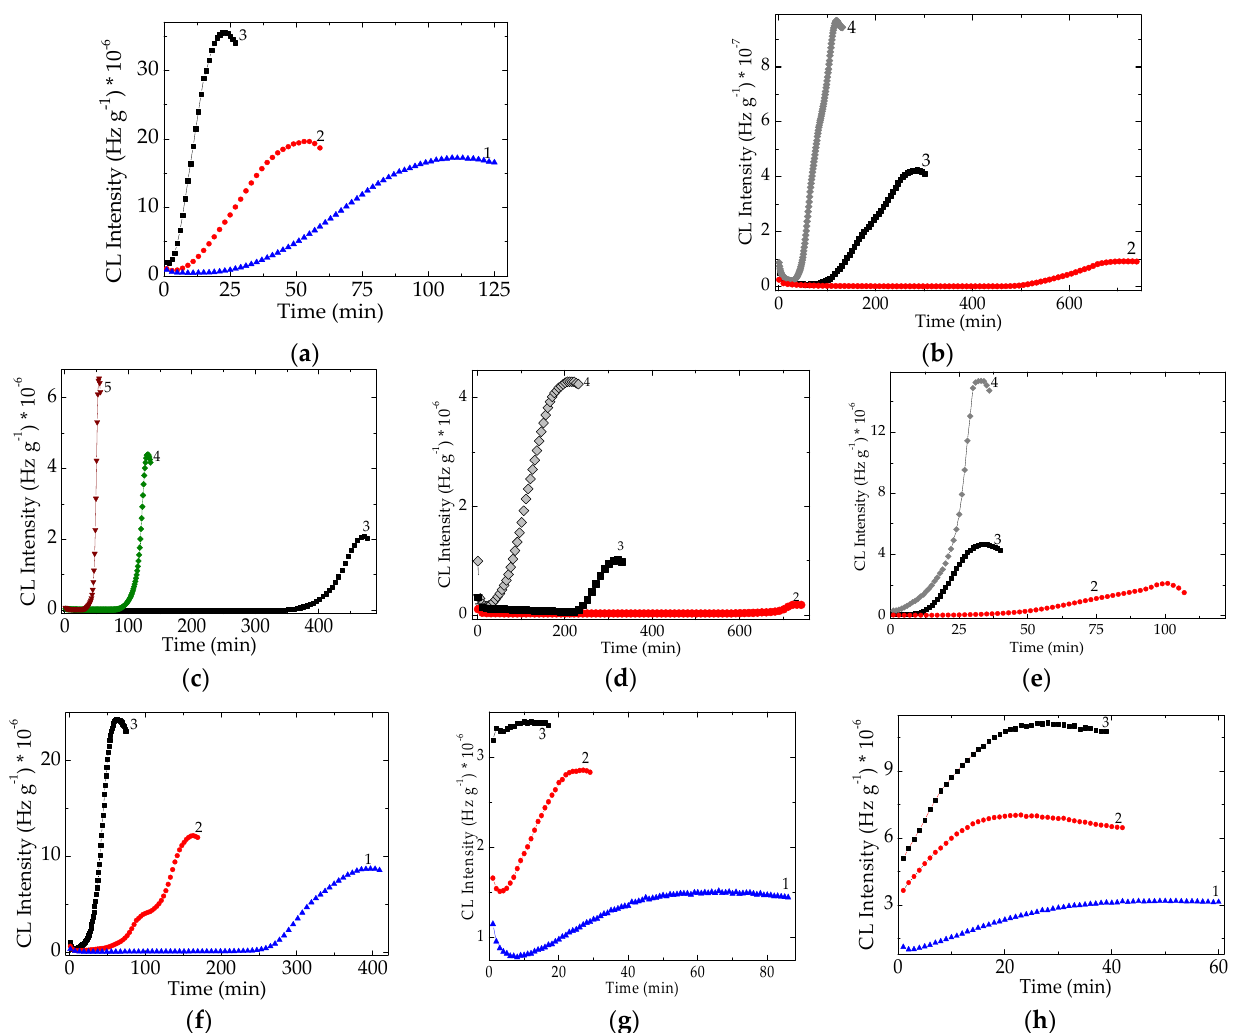
Figure 5. Isothermal CL spectra obtained on various compositions of EPDM samples. ( a ) pristine EPDM; ( b ) EPDM/rosemary; ( c ) EPDM/capsaicin; ( d ) EPDM/quercetin ( e ) EPDM/oleanolic acid; ( f ) EPDM/POSS 1 phr; ( g ) EPDM/POSS 3 phr; ( h ) EPDM/POSS 5 phr. Irradiation dose: 0 kGy. Testing temperature:( 1 ) 160 °C; ( 2 ) 170 °C; ( 3 ) 180 °C; ( 4 ) 190 °C; ( 5 ) 200 °C.